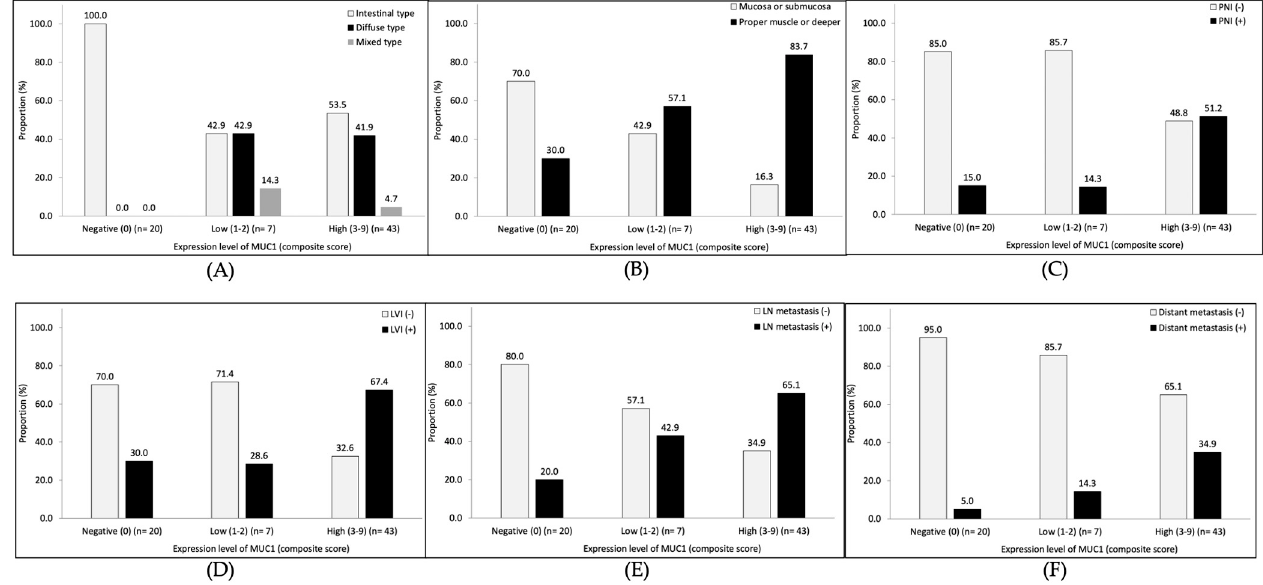
Figure 3. The association between the level of MUC1 expression and pathological features. ( A ) Lauren classification, ( B ) tumor depth, ( C ) perineural invasion (PNI), ( D ) lymphovascular invasion (LVI), ( E ) lymph node (LN) metastasis, and ( F ) distant metastasis.